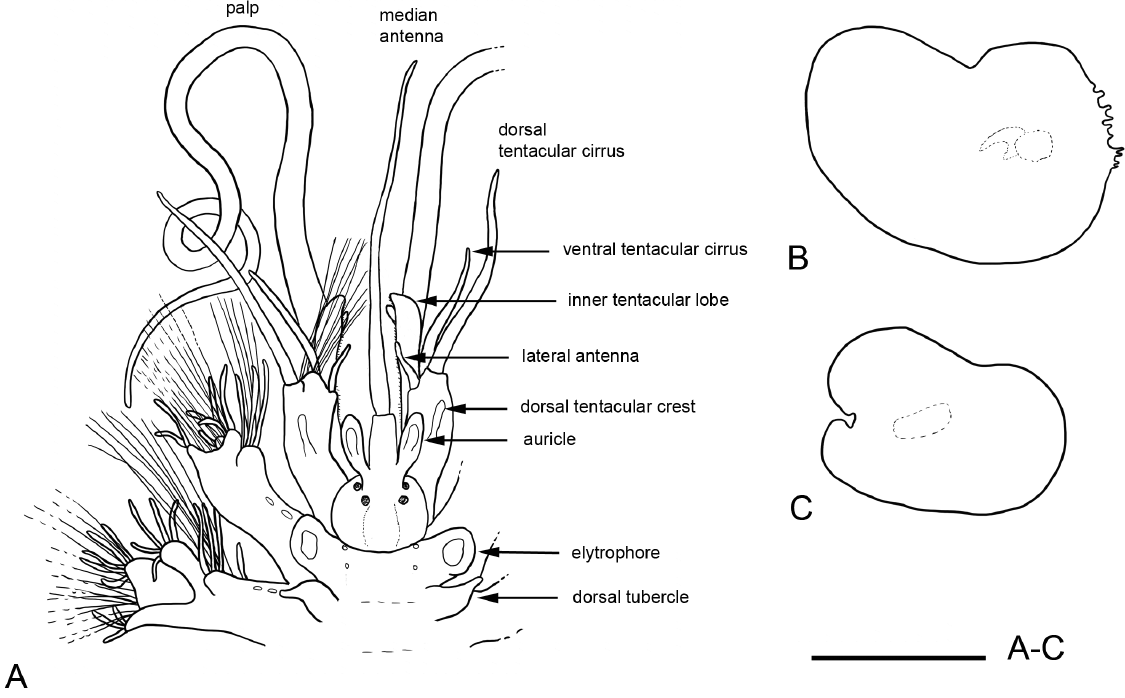
Fig. 1. Sthenelais limicola (Ehlers, 1864), modified from Pruvot & Racovitza (1895) (A) and TUM 37563 (B–C). A . Anterior end, chaetae on right side of prostomium not figured. B . Right elytron of segment 7. C . Left elytron of posterior segment. Scale bar: 1